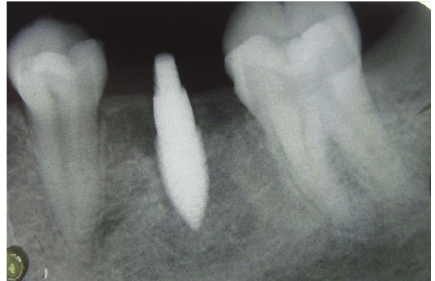
Figure 6: Wrench used for tightening implant.